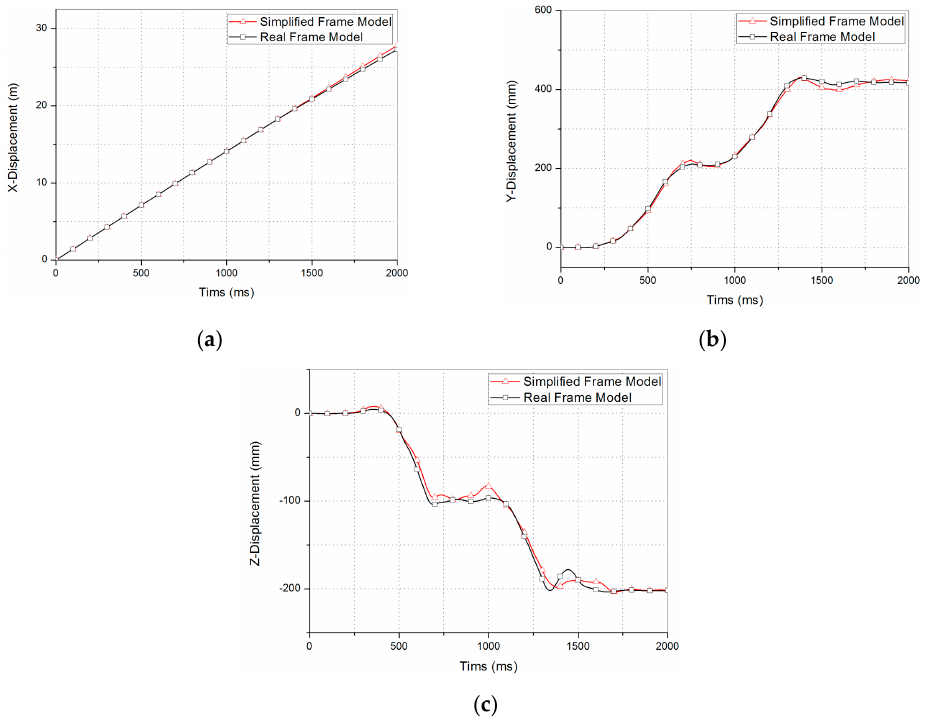
Figure 19. Comparison between the real frame model and the simplified frame model. ( a ) Longitudinal displacement ( b ) Lateral displacement ( c ) Vertical